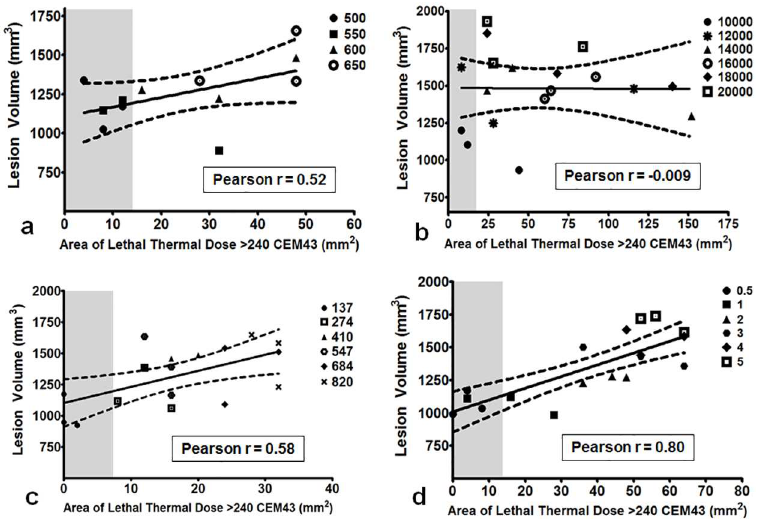
Fig 7. Correlation between lesion volume and area of lethal thermal dose greater than 240 CEM43. Grey area corresponds to 13 mm 2 , which is the area of each sonicationlayer. Any data point within this gray area corresponds to sonicationparameters that producethermal dose in an area equal to or less than the target area (13 mm 2 ). a . Positive, insignificant correlation (Pearsonr = 0.52, p = 0.08) was found betweenthe two variableswhile varyingacoustic power. b . No correlationwas found whilevarying the numberof cycles/ pulse (Pearsonr = -0.009, p = 0.97). c . Positive, strong correlationwas found whilevarying total sonication time (Pearsonr = 0.58, p (cid:20) 0.001). d . Correlationbetweenlesionvolume and area of lethal thermal dose while varyingPRF was also significantly positive (Pearsonr = 0.80, p (cid:20) 0.001).